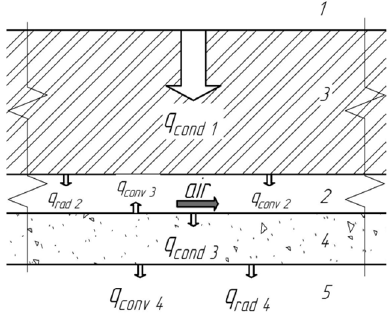
Figure 1. Scheme of heat transfer: 1—internal space of the technological equipment; 2—air duct for recuperation of the heat loss, type the heat curtain; 3—lining; 4—thermal insulation of the lining to reduce dissipative heat loss; 5—environment; 𝑞 (cid:3030)(cid:3042)(cid:3041)(cid:3031) (cid:2869) , 𝑞 (cid:3030)(cid:3042)(cid:3041)(cid:3031) (cid:2871) —conductive heat flow; 𝑞 (cid:3030)(cid:3042)(cid:3041)(cid:3049) (cid:2870) , 𝑞 (cid:3030)(cid:3042)(cid:3041)(cid:3049) (cid:2871) , 𝑞 (cid:3030)(cid:3042)(cid:3041)(cid:3049) (cid:2872) —convective heat flow; 𝑞 (cid:3045)(cid:3028)(cid:3031) (cid:2870) , 𝑞 (cid:3045)(cid:3028)(cid:3031) (cid:2872) —radiation heat flow.